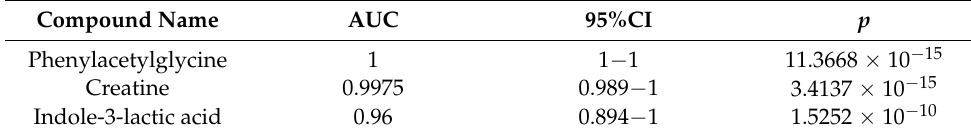
Table 2. The diagnostic efficacy of various metabolites in plasma